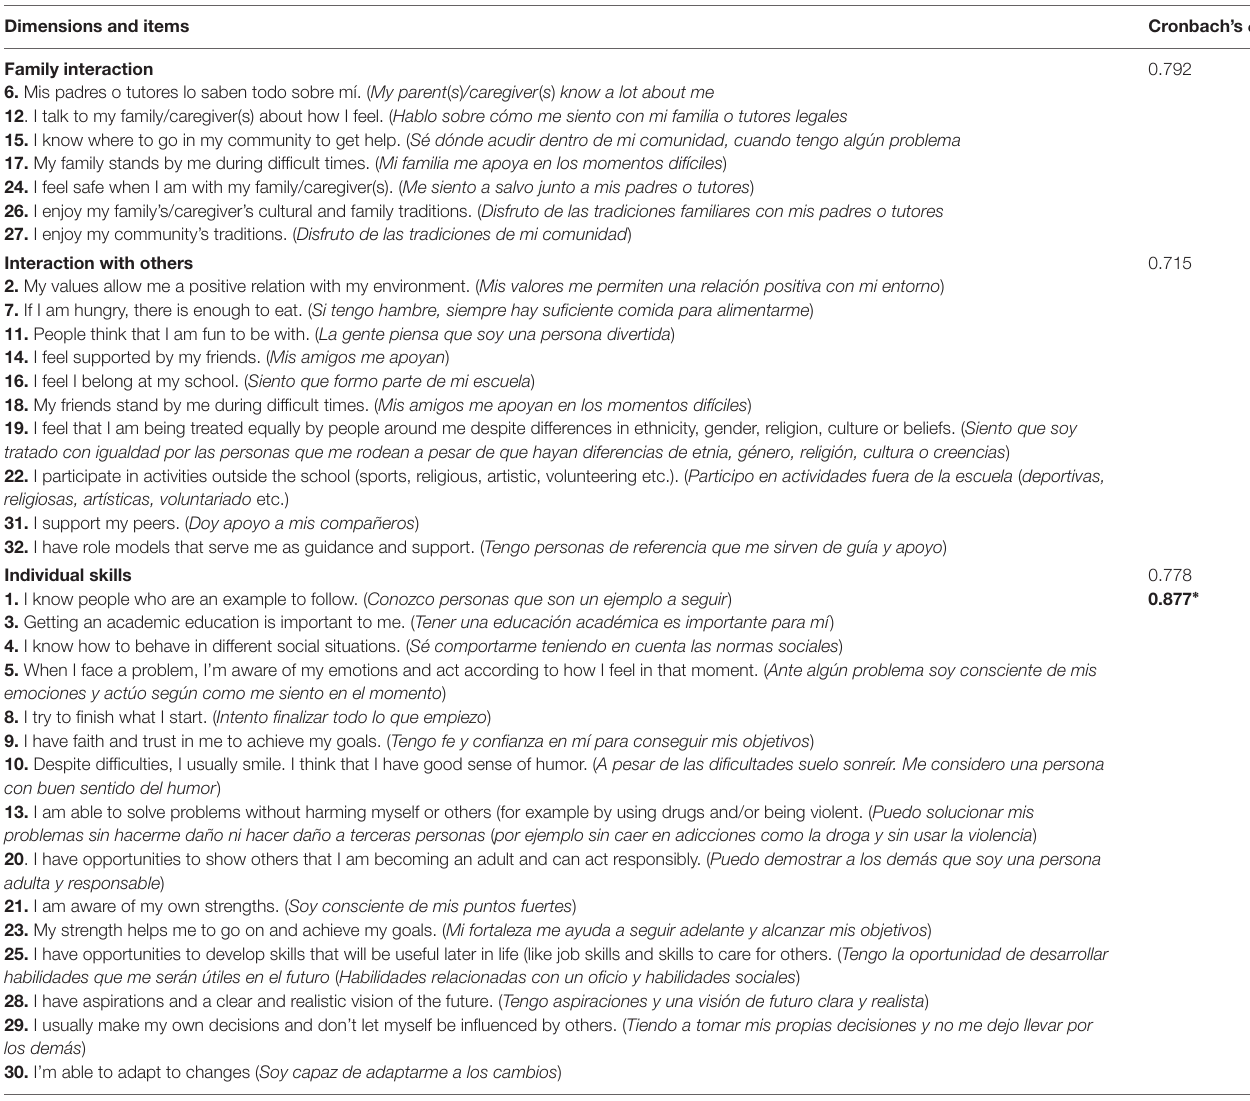
TABLE 4 | CYRM-32 item’s scale and its three